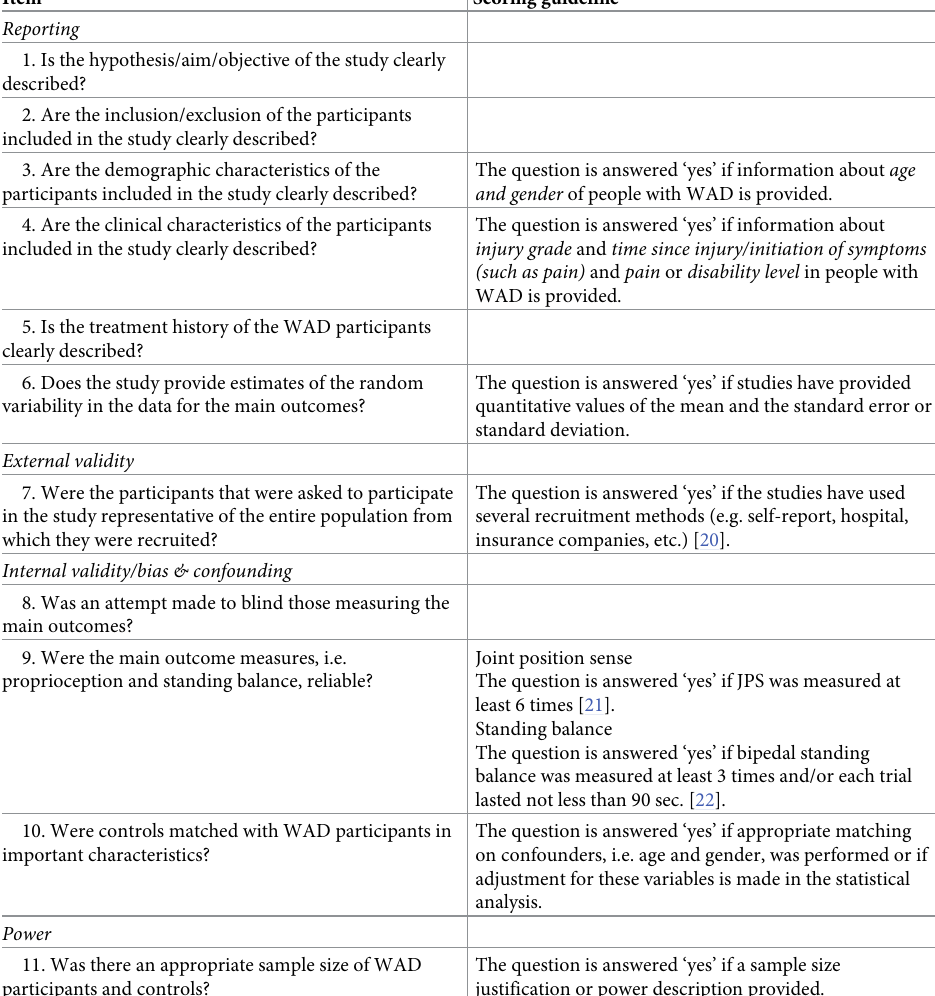
Table 2. Quality rating instrument adjusted specifically for the current review (informed mainly by Downs and Black